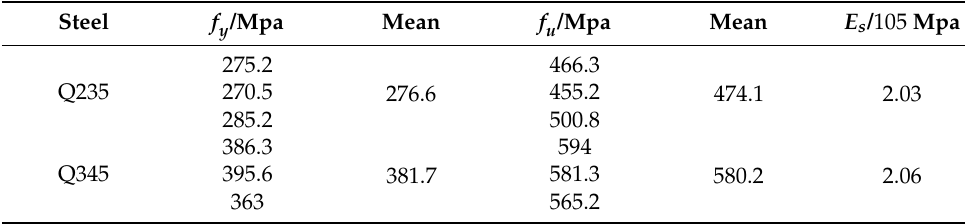
Table 3. Mechanical properties of steel.